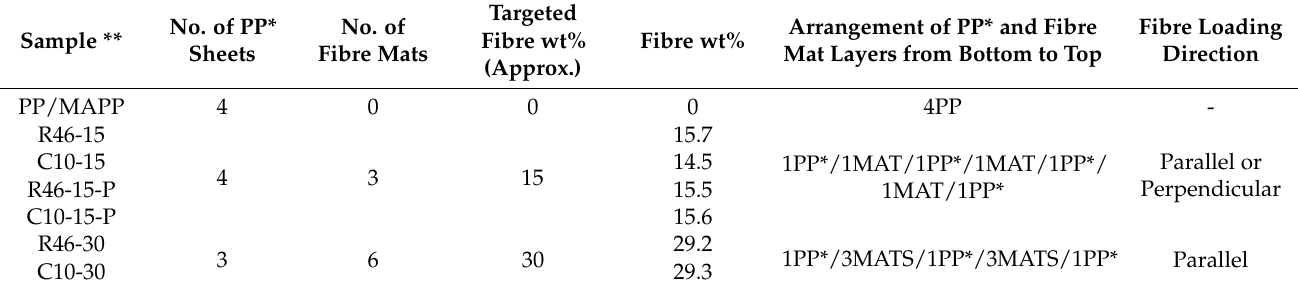
Table 2. Material lay-up in the